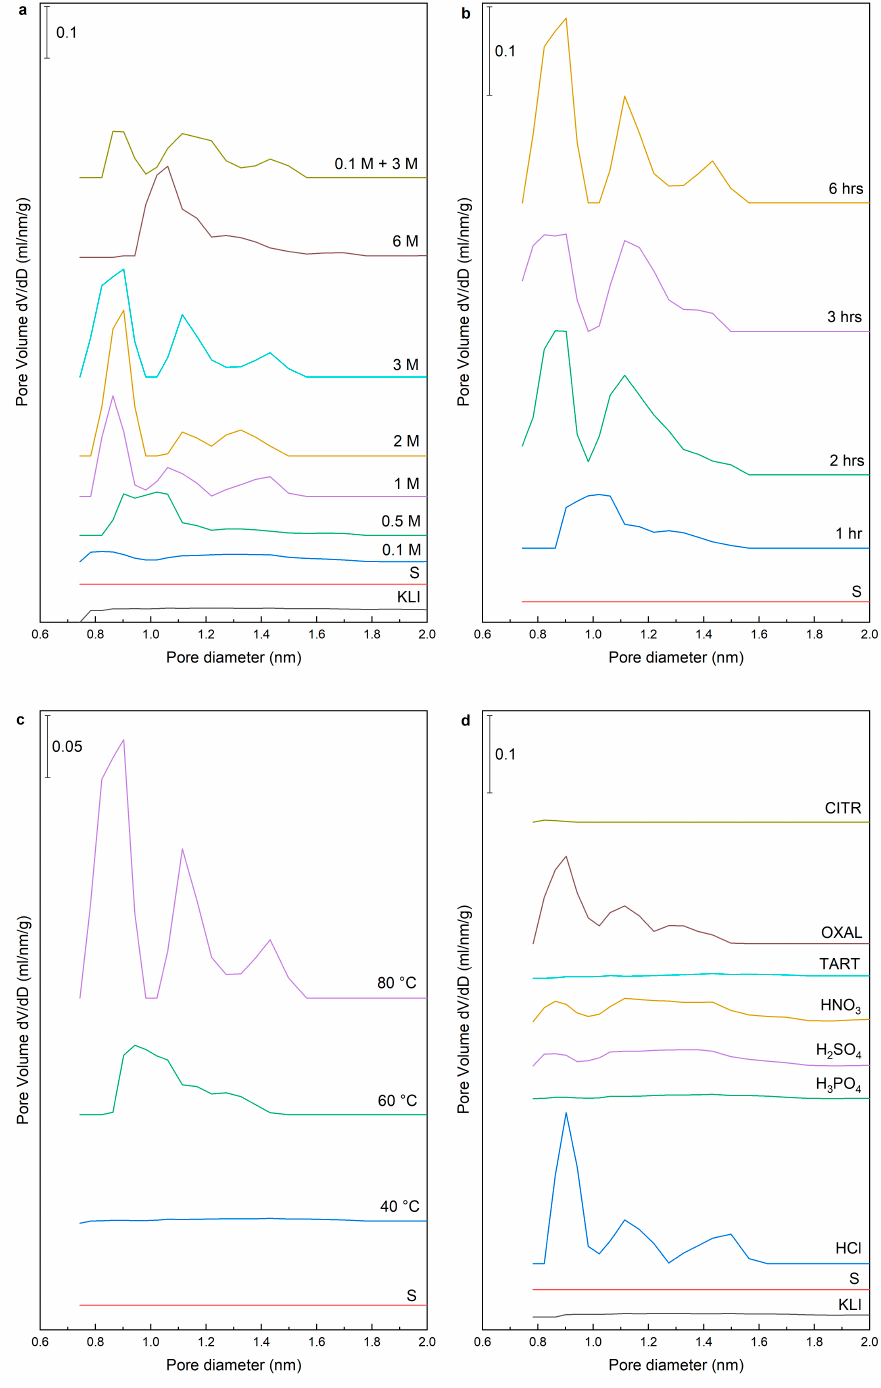
Figure 5. Micropore distribution of modified foams: Influence of acid concentration ( a ), time ( b ), temperature ( c ), and type of acid ( d